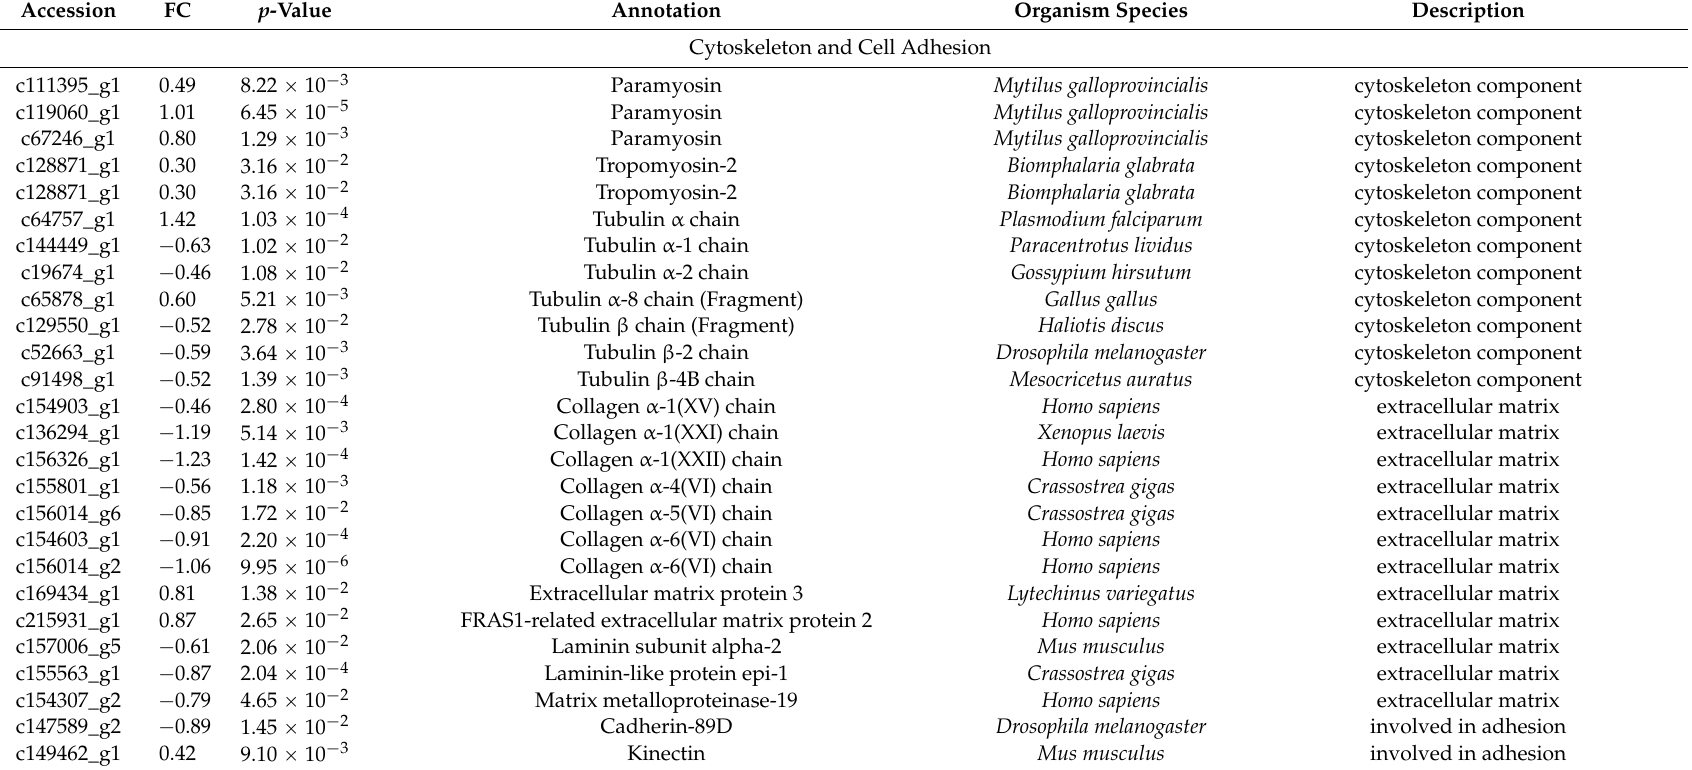
Table 2. Selected differentially expressed proteins (DEPs) between competent larvae and post-larvae. “FC” represents Log 2 (competent larvae /post